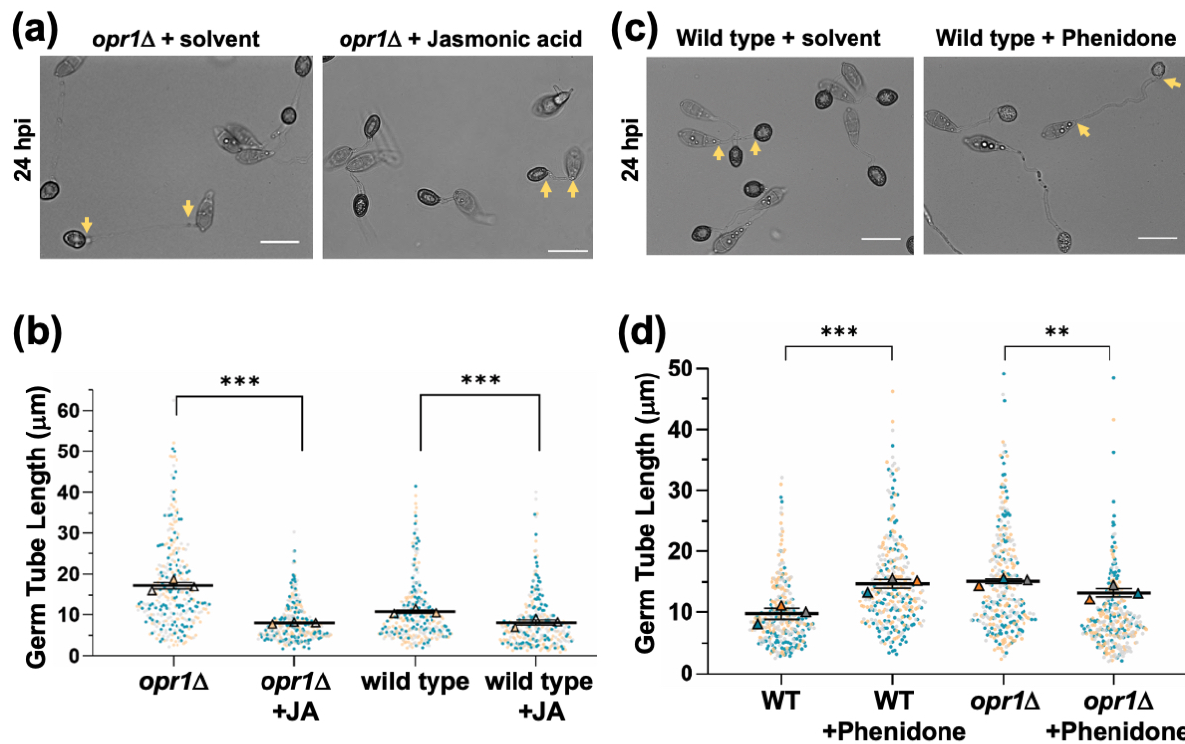
Figure 2. Exogenous JA suppresses germ tube defects in the opr1 ∆ mutant. ( a ) Conidia from the opr1 ∆ strain were inoculated on inductive surface in the presence (0.2 mM) or absence (mock/solvent control) of exogenous jasmonic acid, and germ tube and appressorial development were assessed and quantified at 24 hpi. Germ tube length was indicated by 2 arrows in each panel. Scale bar = 10 µ m. ( b ) Exogenous JA significantly represses germ tube growth in opr1 ∆ and WT strain. Data represents mean ± SE from 3 independent repeats of the experiment, each involving at least 100 conidia. Each dot represents the value in the data from three biologically independent repeats ( n = 300). Two-tailed t -test was performed to test the differences among the samples, ** p <0.01; *** p <0.001. ( c , d ) Chemical inhibition of JA synthesis (phenidone) results in elongated germ tubes and recapitulates the opr1 ∆ phenotype in the wild-type M. oryzae strain. Conidia from the WT strain were inoculated on inductive surface in the presence or absence of the JA-inhibitor Phenidone, and germ tube and appressorial development quantified at 24 hpi. Germ tube length was delineated by 2 arrows in each panel. Scale bar = 10 μ m. Quantification performed as detailed for panel b above.